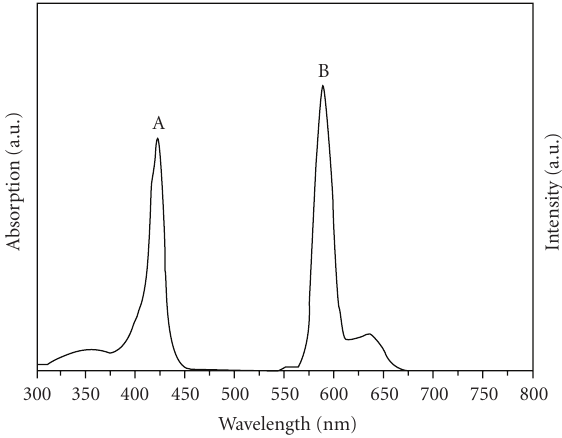
Figure 1: Absorption (A) and emission (B) spectrum of ZnPP.